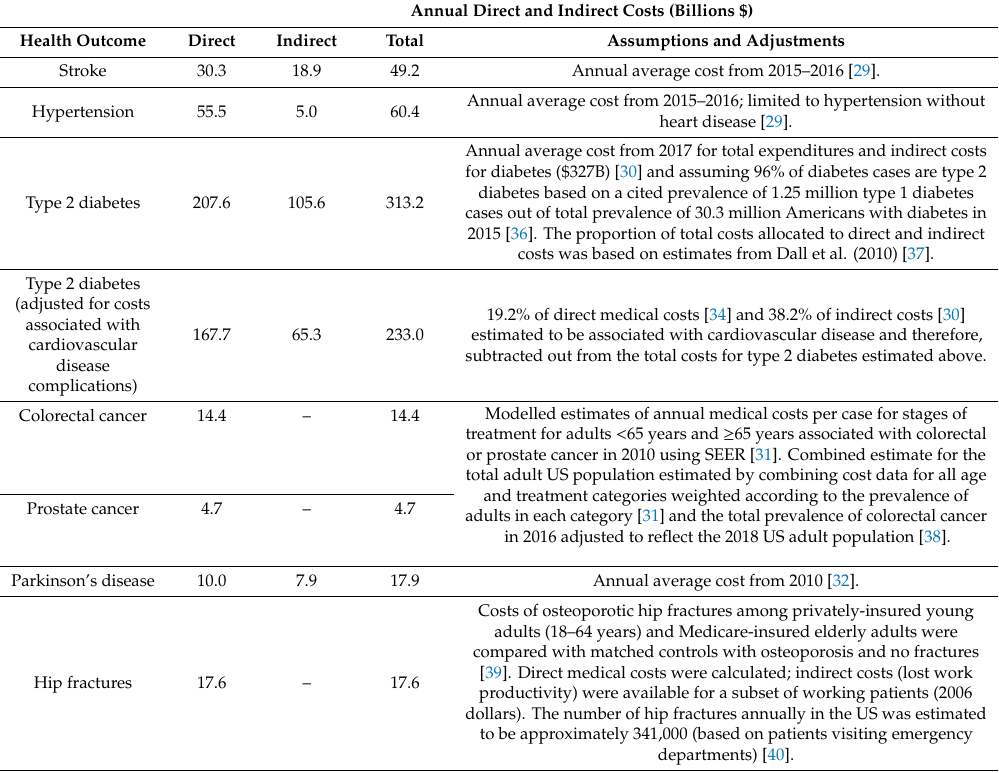
Table 3. Estimated annual direct and indirect health care costs (Billions $) for selected health outcomes based on published